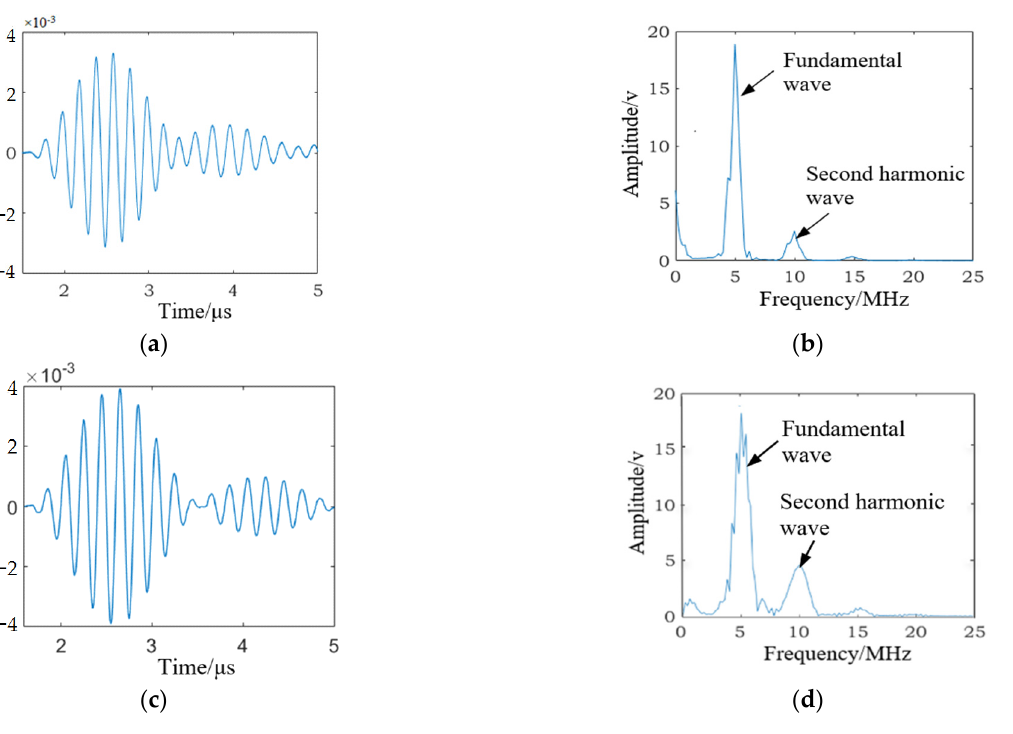
Figure 6. The SLM 316 L stainless steel specimen subjected to different fatigue cycles. ( a ) The received time-domain signal subjected to 10,000 fatigue cycles. ( b ) The frequency spectra of the received signal subjected to 10,000 fatigue cycles. ( c ) The received time-domain signal subjected to 10,000 fatigue cycles. ( d ) The frequency spectra of the received signal subjected to 10,000 fatigue cycles.